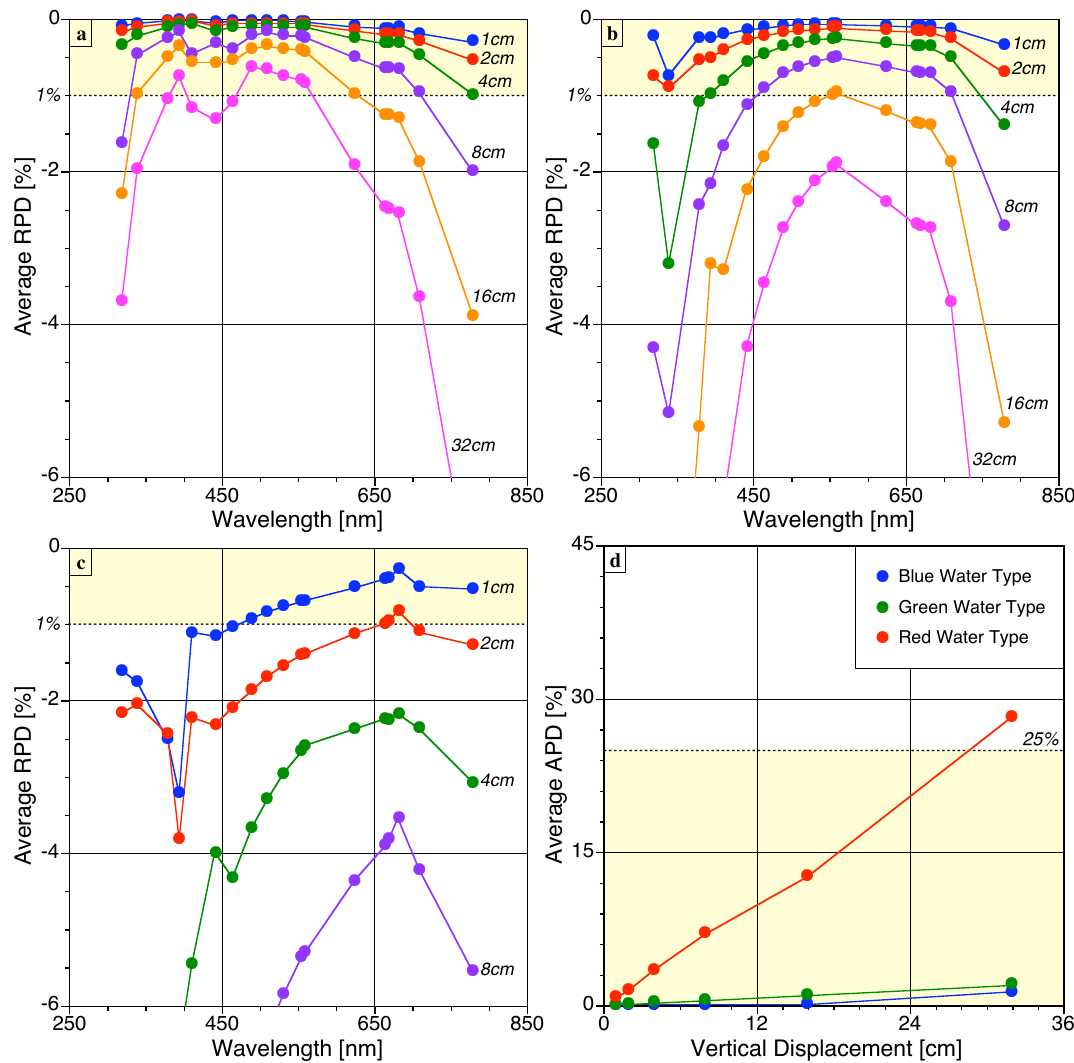
Fig. 4. The degradation in deriving data products from high-resolution C-OPS profiles as a result of incorrectly altering the vertical offset between the pressure transducer and the sensor apertures. The degradation is expressed as the RPD between the results obtained for the original processing parameters with correct offsets versus the subsequent processing results wherein the vertical offset was incorrectly displaced by 1, 2, 4, 8, 16, and 32cm (as shown using a unique color for each vertical displacement value). The four panels correspond to the degradation analyses in L W (λ) for (a) the blue water type, (b) the green water type, and (c) the red water type, as well as to (d) the degradation in the derived chlorophyll a concentration (using the OC4v5 band ratio algorithm) as a function of the aforementioned water types and the six vertical displacement